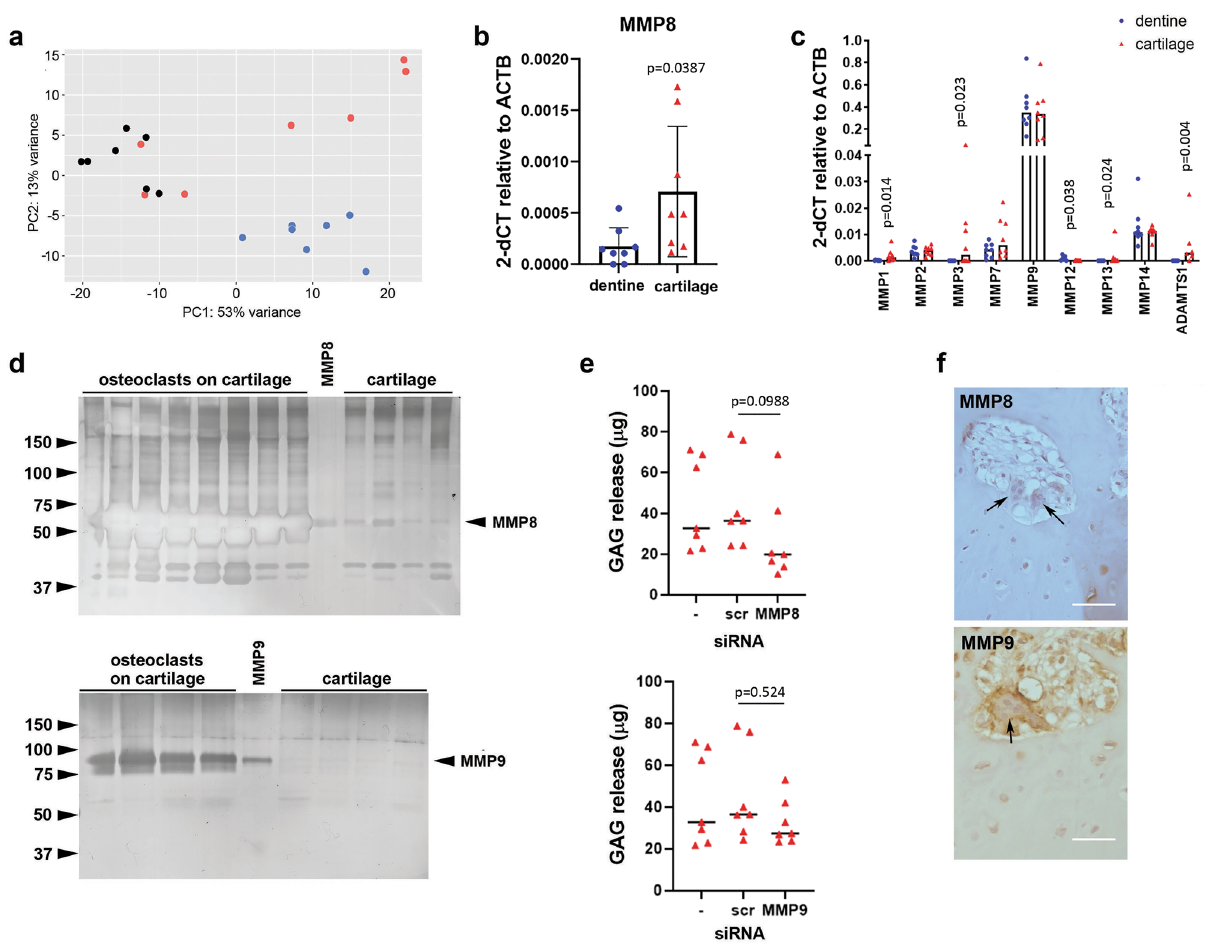
Figure 4. MMP8 and MMP9 drive osteoclast-mediated release of GAG from cartilage. ( a ) Principal Component Analysis (PCA) plot of osteoclasts on acellular cartilage (red), dentine (blue) and cell culture plastic (black), n = 7. ( b , c ) RT-qPCR analysis of differences in expression of MMPs by osteoclasts differentiated on dentine or acellular cartilage: ( b ) MMP8 (n = 8; T test); ( c ) MMP1, 2, 3, 7, 9, 12, 13, 14 and ADAMTS1 (n = 8; multiple Mann–Whitney). ( d ) Representative zymography of MMP8 and MMP9 from the conditioned media of osteoclasts differentiated on acellular cartilage compared to recombinant protein and cartilage alone. ( e ) GAG released by osteoclasts differentiated on acellular cartilage and transfected with siRNA targeting MMP8 or MMP9 on day 7 of differentiation, versus no siRNA (−) and scrambled siRNA (scr) controls (n = 7; Kruskal– Wallis ANOVA). ( f ) Human OA tissue sections stained for MMP8 (top) and MMP9 (bottom). Arrows indicate multinucleated osteoclasts. Scale bar = 100